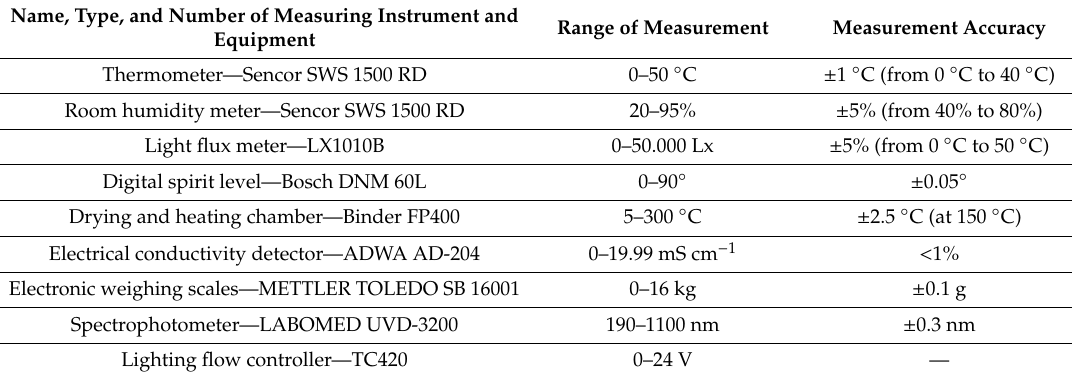
Table 1. Equipment and measuring instruments used in the